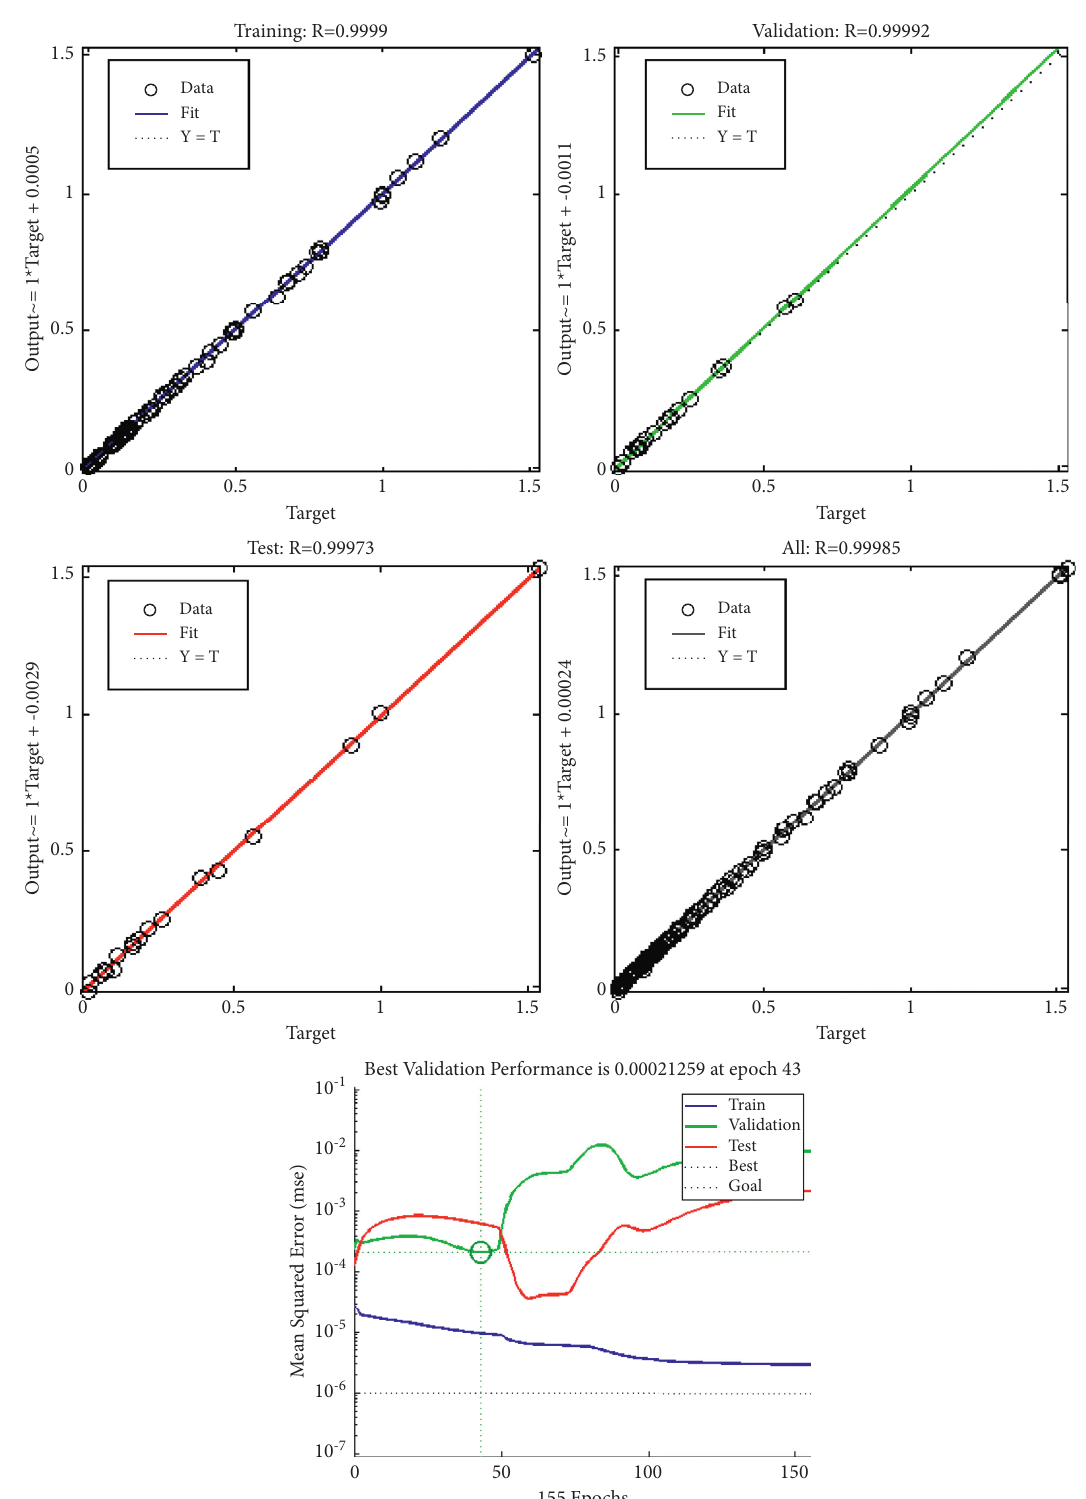
Figure 4: Training performance of the generated neural network with 2 inputs (temperature and drying time), 10 hidden layer neurons, and 2 outputs (moisture content and moisture